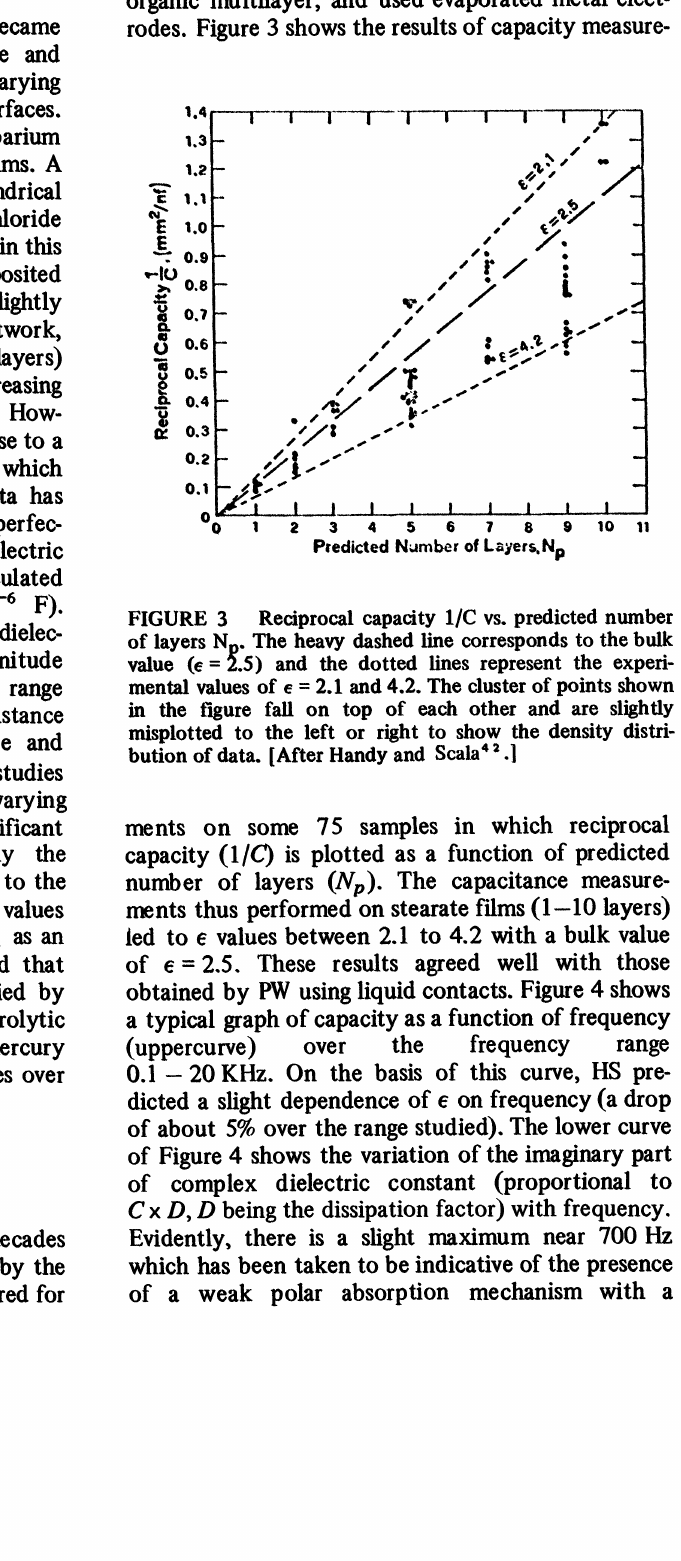
Reciprocal capacity 1/C vs. predicted number of layers Nv. The heavy dashed line corresponds to the bulk value (e 2.5) and the dotted lines represent the experi- mental values of e 2.1 and 4.2. The cluster of points shown in the figure fall on top of each other and are slightly misplotted to the left or right to show the density distri- bution of data. [After Handy and